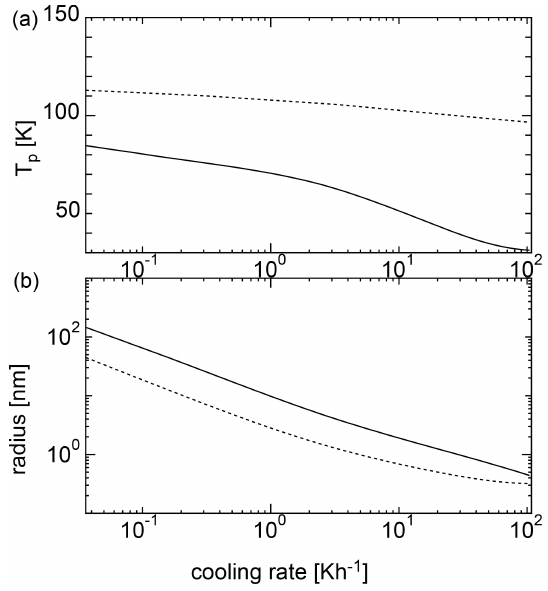
Figure 4. Nucleation temperatures (a) and mean particle radii (b) for homogeneous nucleation with an initial temperature of 135K. The solid curve shows the results of the SP model, and the dotted curve shows the results of the MCNT model.